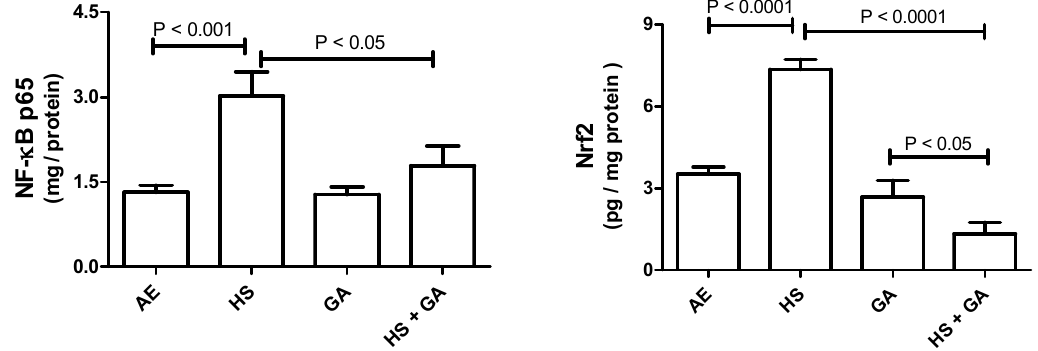
Figure 5. The testicular homogenate concentrations of nuclear factor kappa B (NF-kB) and nuclear factor erythroid 2-related factor-2 (Nrf2) in mice exposed to normal air (AE) and hookah smoke (HS, 30 min/day) or treated with gum acacia (GA, 15% w / v ) with or without exposure to HS. Each vertical column with bar represents the mean ± SEM ( n = 8). The P < 0.05 was considered significant.